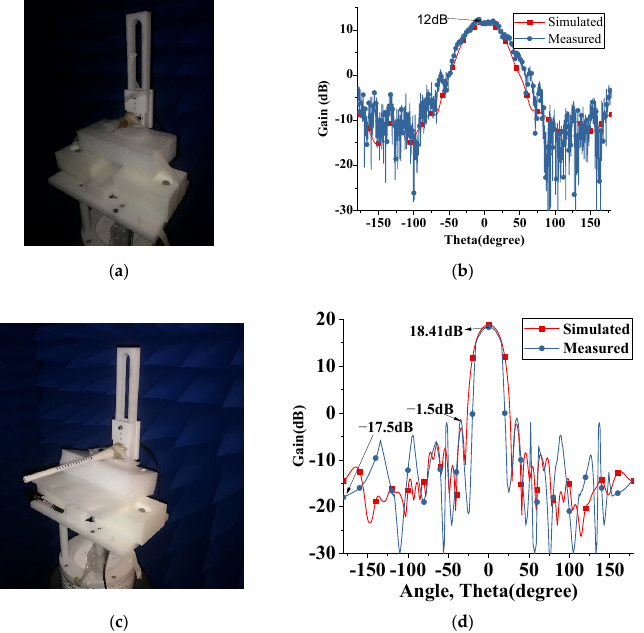
Figure 13. ( a ) Radiation patterns Measurement setup of Helix ( b ) simulated and measured radiation pattern comparison of Helix alone ( c ) radiation pattern measurement of the proposed structure ( d ) simulated and measured radiation pattern comparison of the proposed structure.